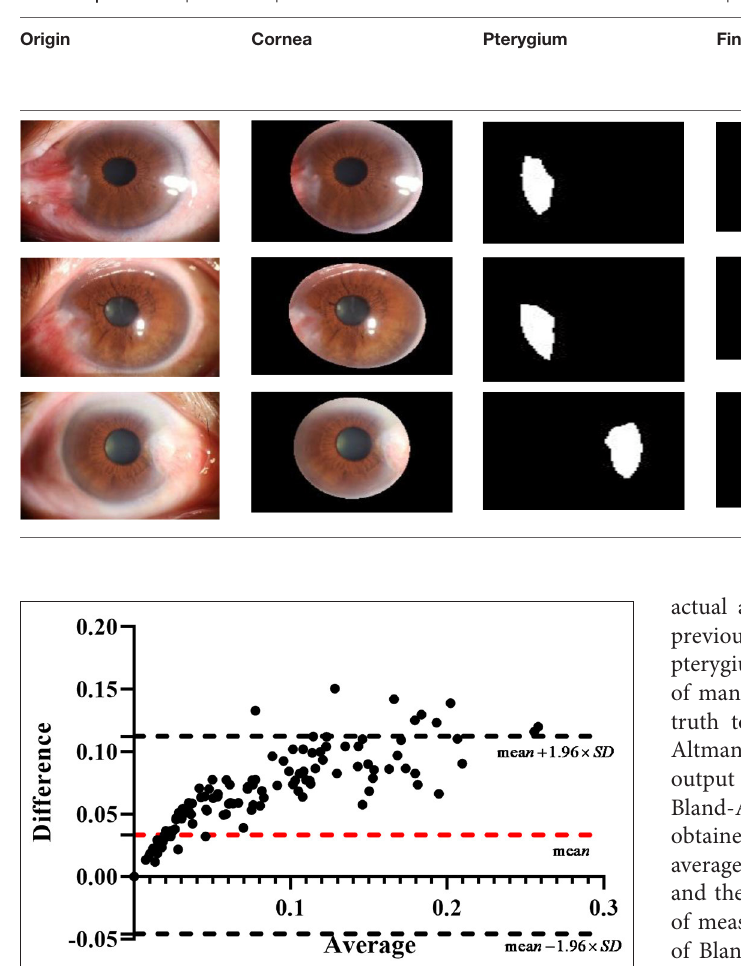
TABLE 7 | Some samples whose prediction results are inconsistent with the doctor’s visual inspection results.